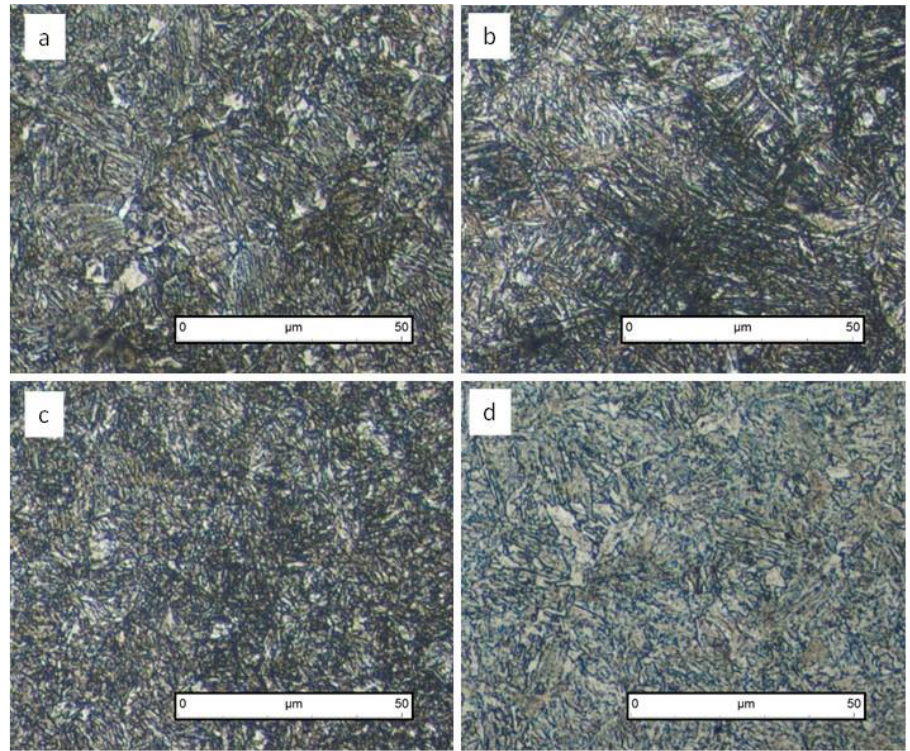
Figure 3. Typical microstructures after quenching + tempering at 450 °C for steels C45E ( a ), 40niCrMo6 ( b ) and 37Cr4 ( c ); ( d ) corresponds to a tempering temperature of 650 °C for a C45E steel.